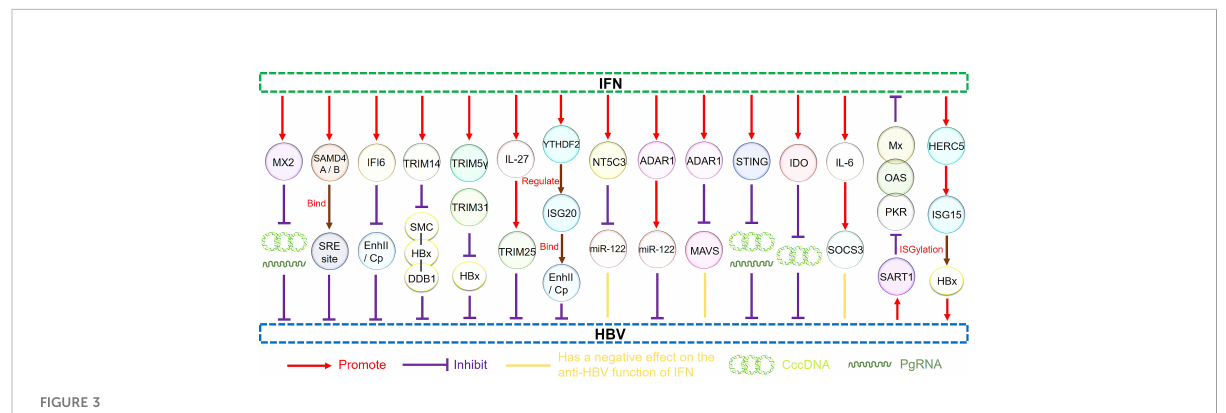
FIGURE 3 The regulatory pathways of